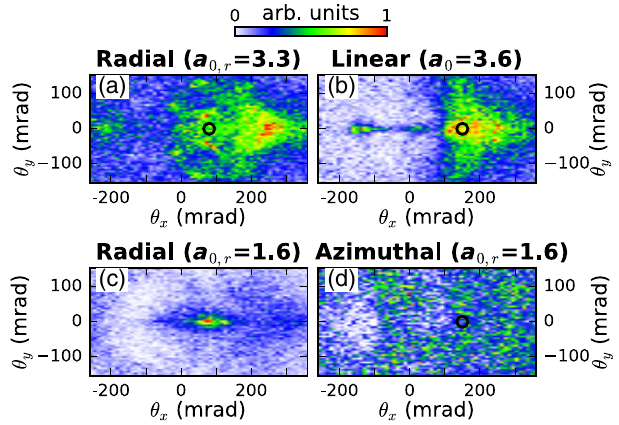
FIG. 7. Results from 3D PIC simulations. Angular distributions of the electrons with an energy greater than 1 MeVobtained at the end of the simulations with (a) radial polarization and a 0 ;r ¼ 3 . 3 , (b) linear polarization and a 0 ¼ 3 . 6 , (c) radial polarization and a ¼ 1 . 6 , and (d) azimuthal polarization and a 0 ;r these images, a value of 1 on the color bar corresponds to 2 . 68 fC = mrad 2 for panel (a), 3 . 72 fC = mrad 2 for panel (b), 1 . 68 fC = mrad 2 for panel (c), and 0 . 45 fC = mrad 2 for panel (d).